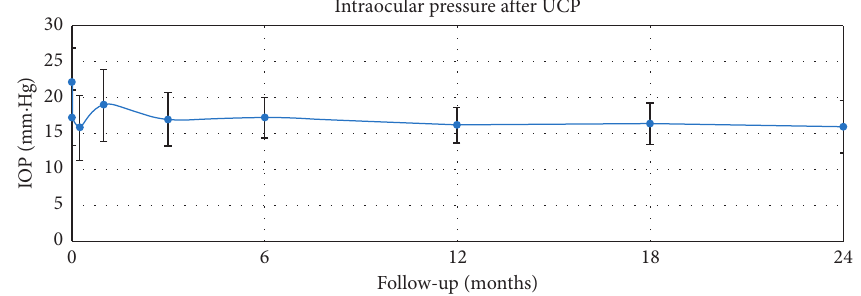
Figure 4: Intraocular pressure after UCP—24-month follow-up.